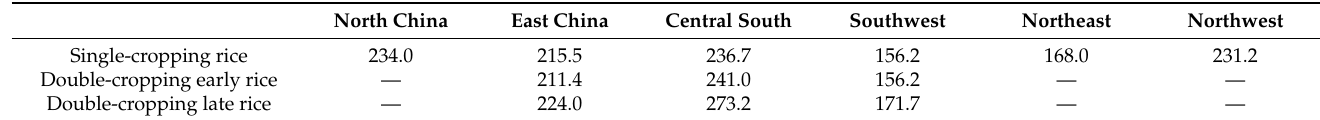
Table 1. Methane emission factors from paddy fields.